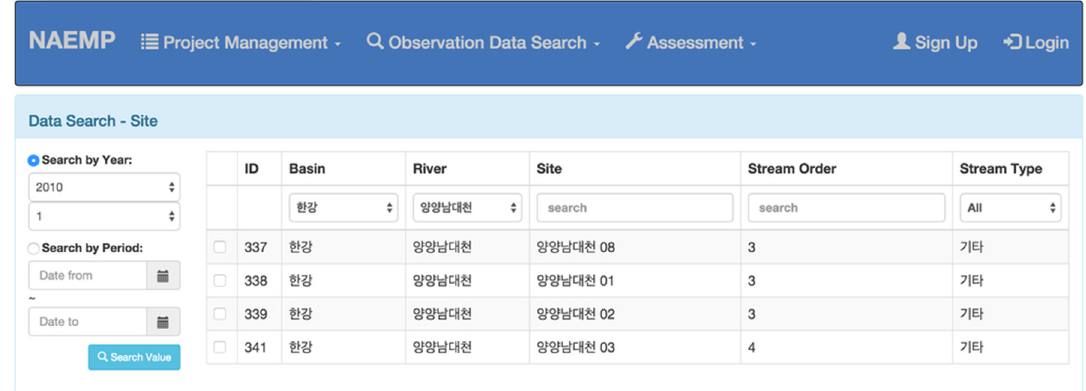
Figure 12. GUI window for the site-based observation data search.